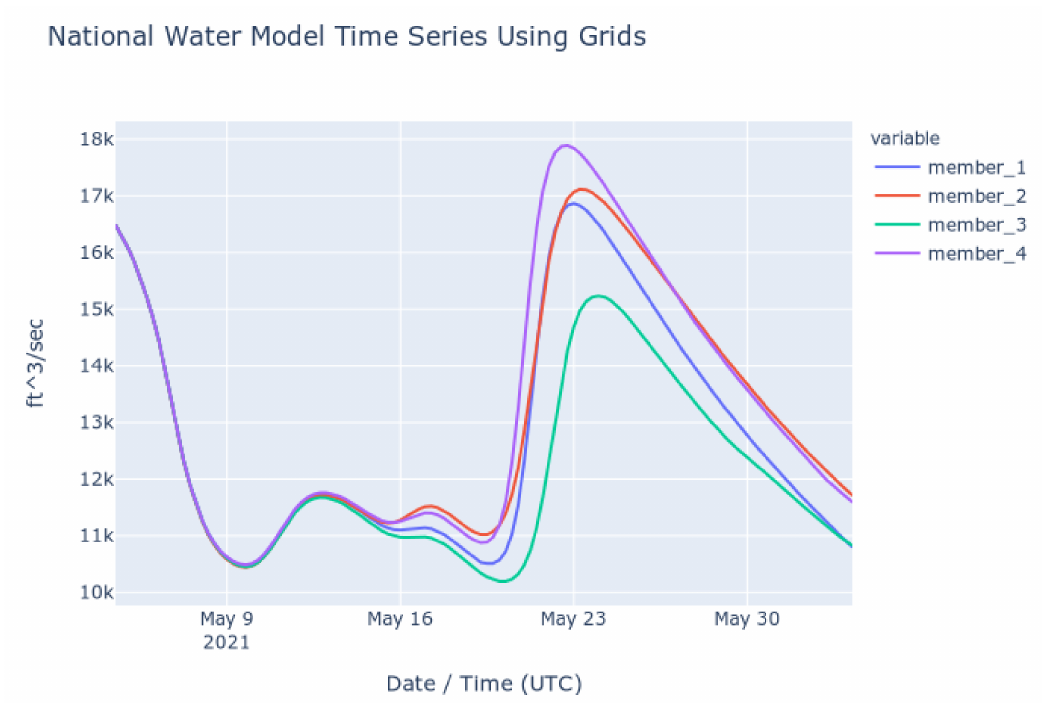
Figure 7. NWM Time Series from Local Files and Grids